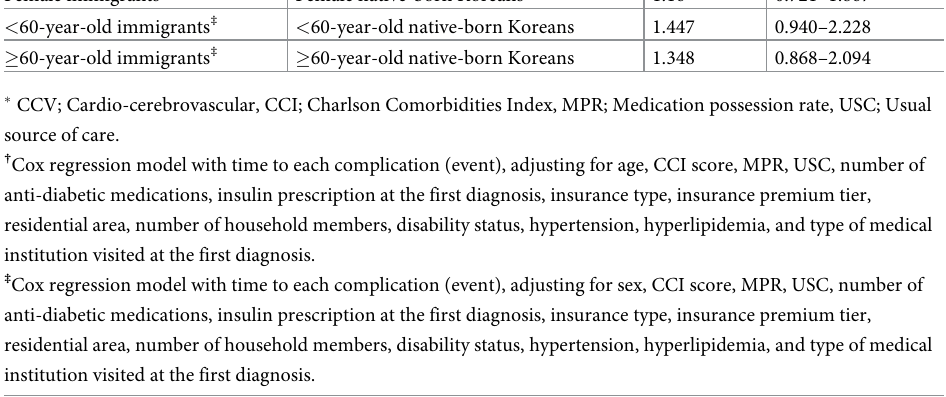
Table 3. Differences in cardio-cerebrovascular complications between immigrants and native-born Koreans by sex and age. Category Reference